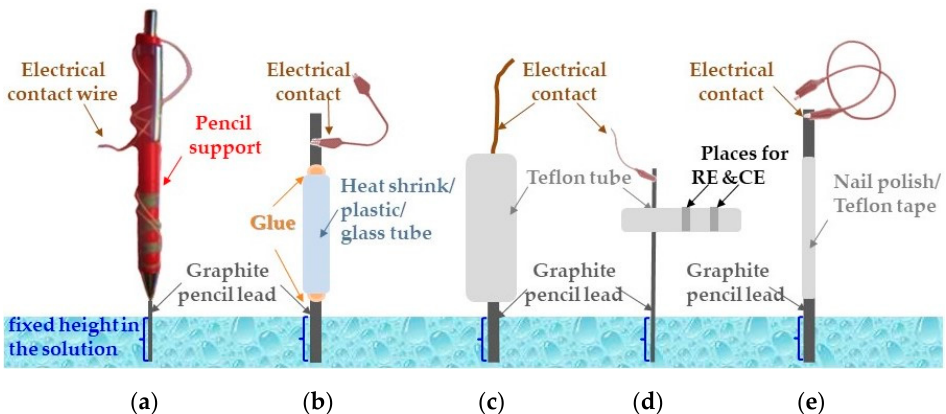
Figure 1. Schematic representation of the most commonly used types of PGEs with the graphite lead ( a ) fixed in a mechanical pencil, ( b ) inserted in a heat shrink, plastic, or glass tube and sealed with glue, ( c , d ) fixed in a Teflon tube, or ( e ) covered with nail polish or a Teflon